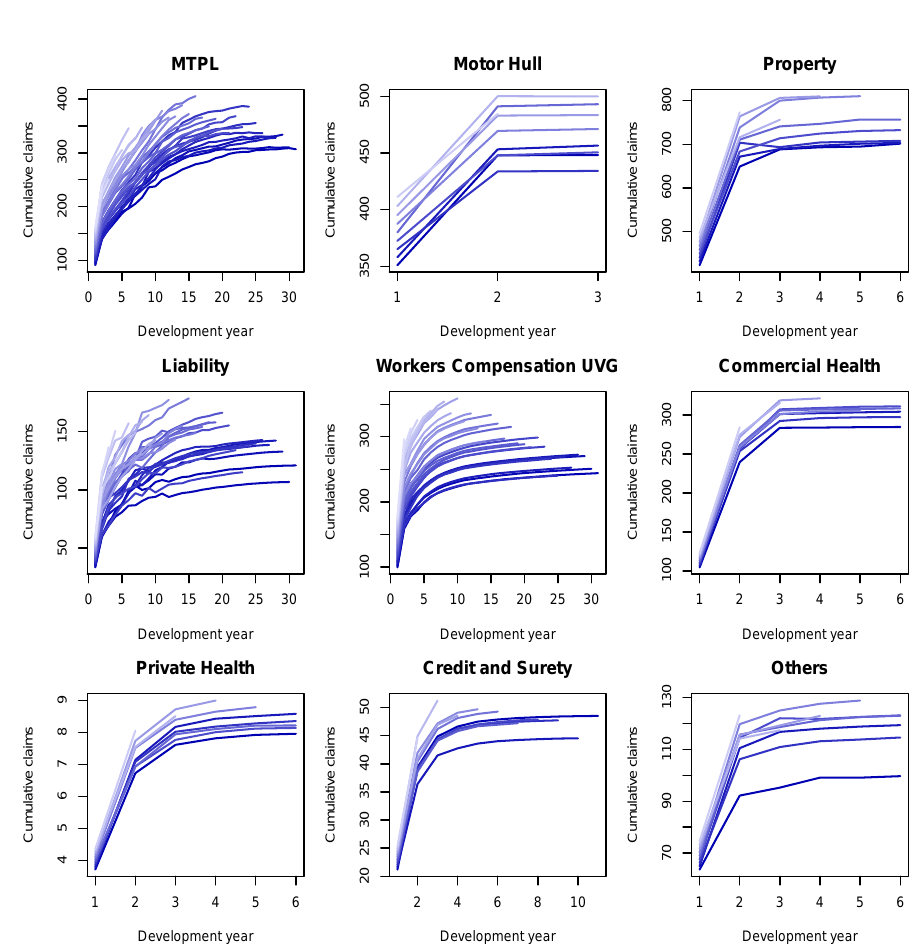
Figure 4. Cumulative claims payment (in millions of CHF). Lighter colours represent more recent accident